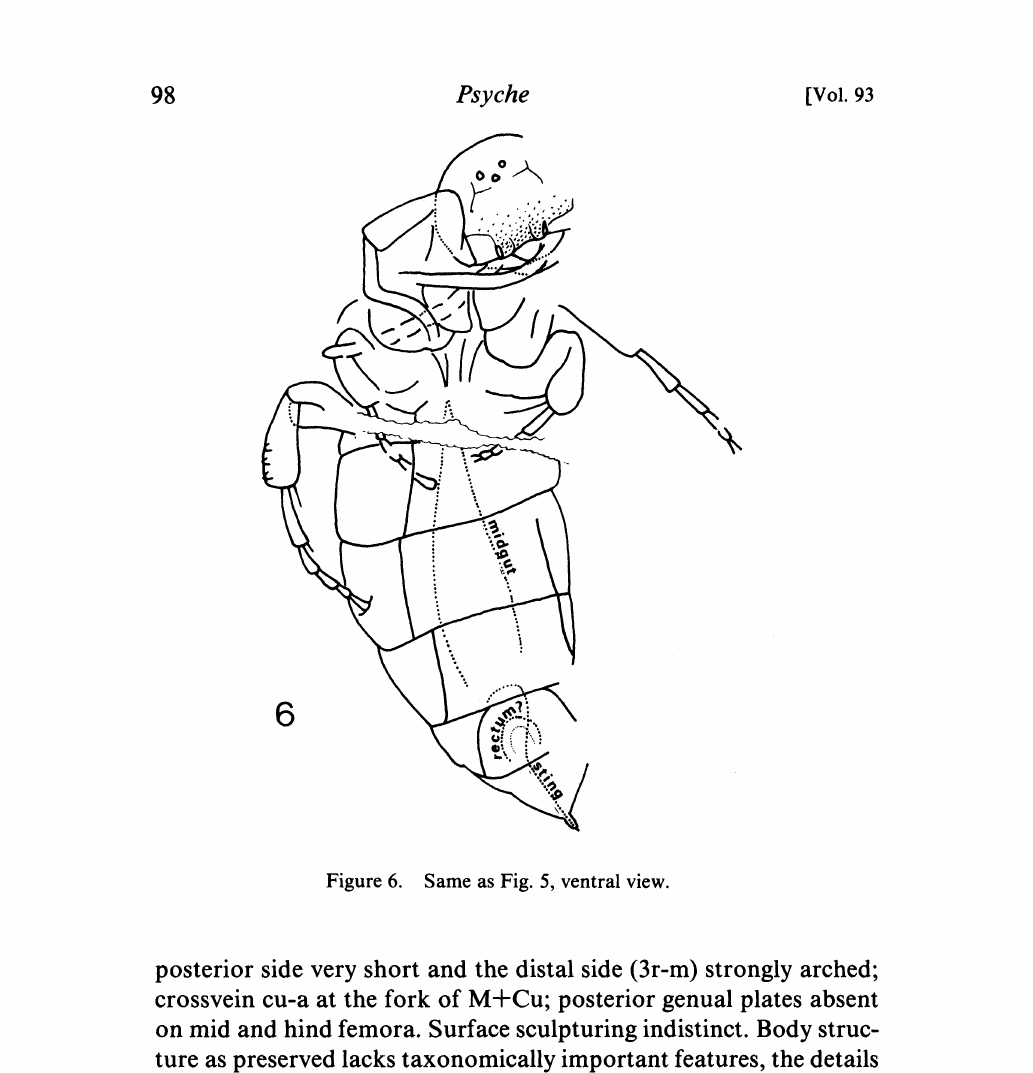
Figure 6. Same as Fig. 5, ventral